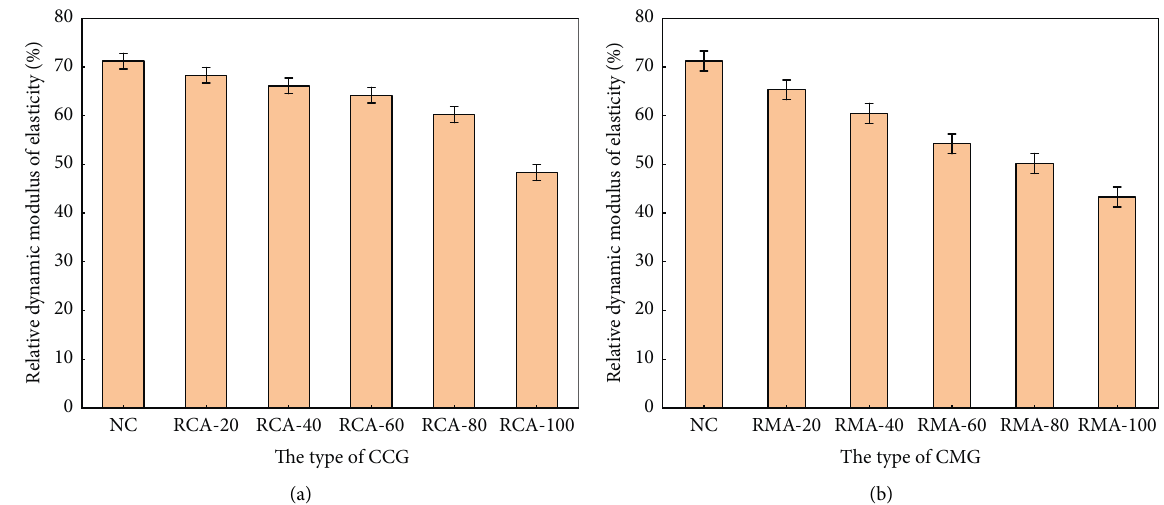
Figure 5: The effect of RCA and RMA with different dosages on relative dynamic elastic modulus of CCG and CMG. (a) CCG, (b) CMG.